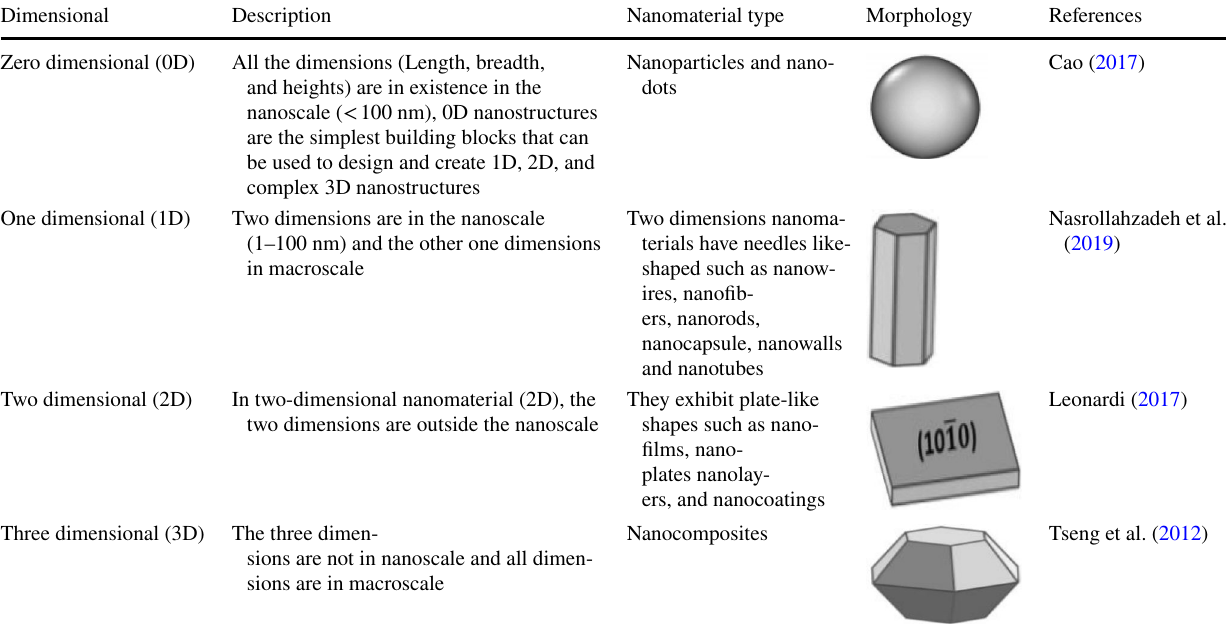
Table 1 Different dimension and descriptions of zinc oxide nanoparticles Dimensional